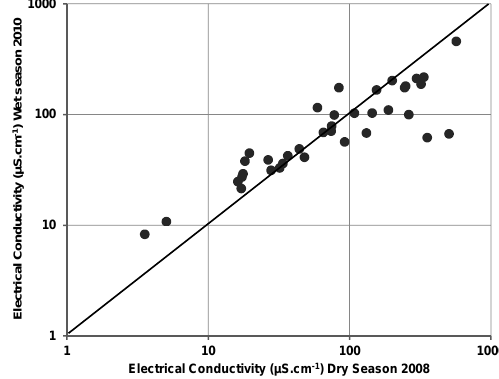
Fig. 2. Location of the sampling NH in the Nhecolˆandia, southern part of the Taquari alluvial fan.